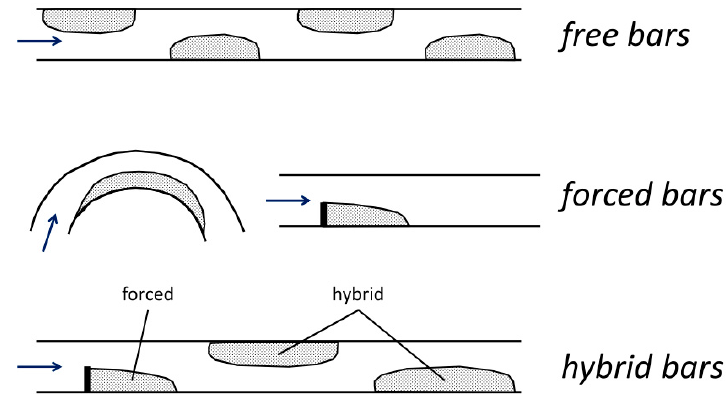
Figure 3. Distinction between free, forced and hybrid bars. Free bars are periodic bars that form spontaneously in the absence of geometrical features or discontinuities causing permanent flow perturbations. Forced bars are single bars that arise at the locations of geometrical features or discontinuities. Hybrid bars are periodic bars that form as a train behind a forced bar.